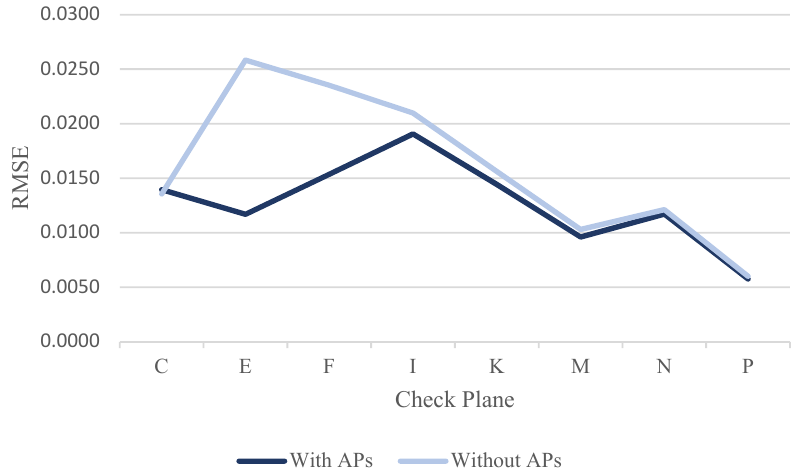
Figure 27. The line chart of RMSE for check planes in dataset Data3.